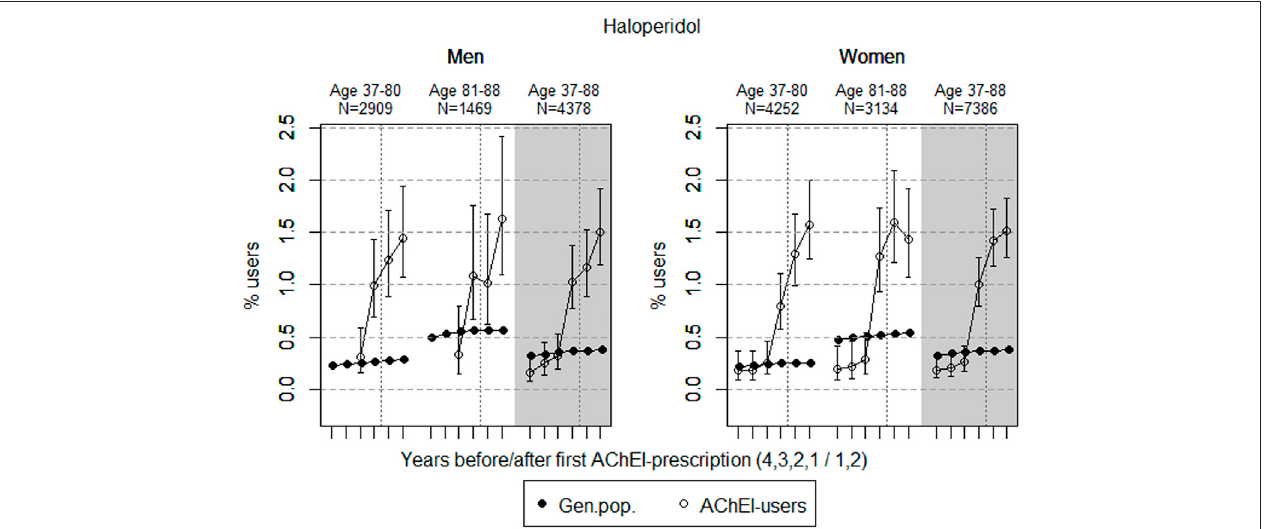
FIGURE 1 | Open circles: Proportion ofmen and women, respectively, of the study population who fi lled at least one prescription ofhaloperidol (ATC N05AD01) in the4 yearsbeforeacetylcholinesteraseinhibitors(AChEI)initiationandthe2 yearsafterwith95%con fi denceintervals.Yearswithlessthan fi veusersinoneorbothofthe age groups arenot shown.Bullets:Thecorrespondingage adjusted proportion inthegeneralpopulation. Dashed verticallinesindicate AChEI initiation. Thesizeofeach age group in the study population is given on top.